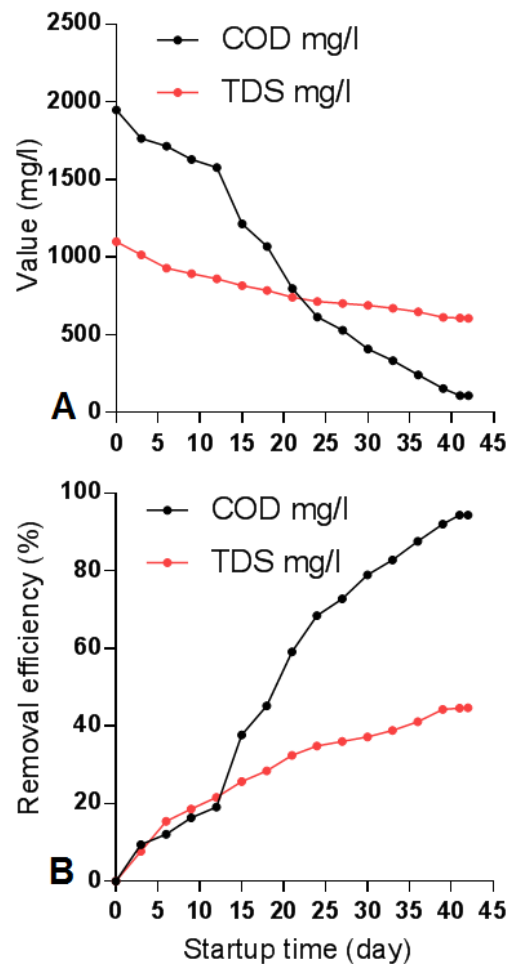
Figure 2. MBBR system startup phase monitoring for chemical oxygen demand (COD) and total dissolved solids (TDS) concentration changes (A) and removal efficiency